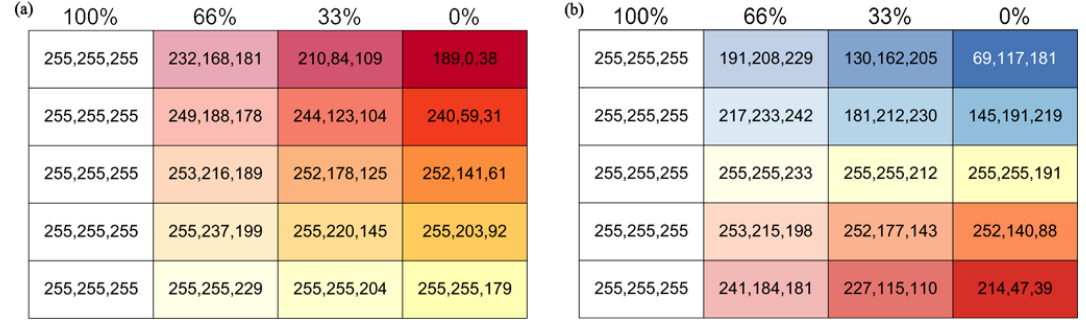
Fig. 7. (a) Adding different proportions of white to the temperature legend shown in Fig. 6a and (b) adding different proportions of white to the precipitation legend shown in Fig.